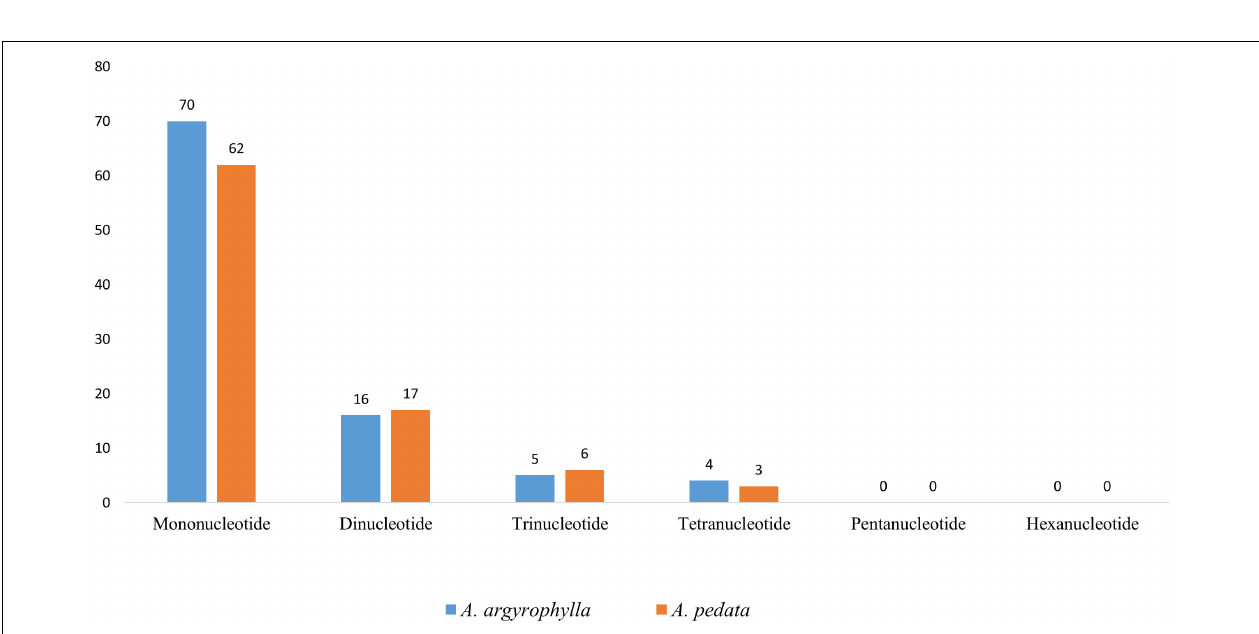
Frontiers in Genetics |